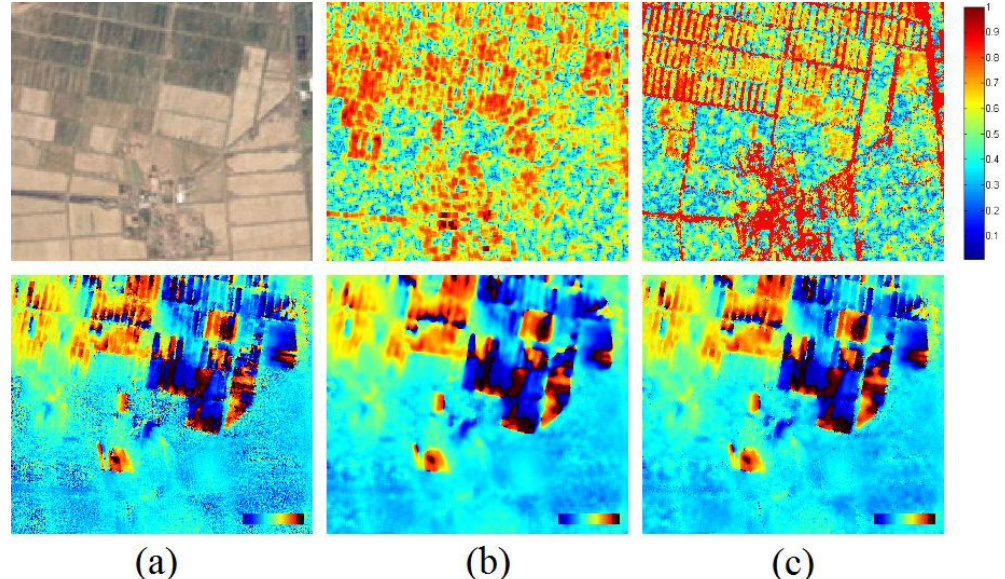
Fig. 3. Comparison of boxcar multilooking and adaptive spatial filtering algorithm, applied on the interferometric data pair acquired on August 13 th , 2013 and September 28 th , 2013. (a) is Landsat TM image and its 1×5 multilooked interferogram, (b) is coherence and interferogram estimate after 4×40 pixels boxcar multilooking, (c) is coherence and interferogram estimate after 4×20 pixels adaptive spatial filtering based on Anderson-Darling test. The vertical interferometric phase change within the paddy field was caused by